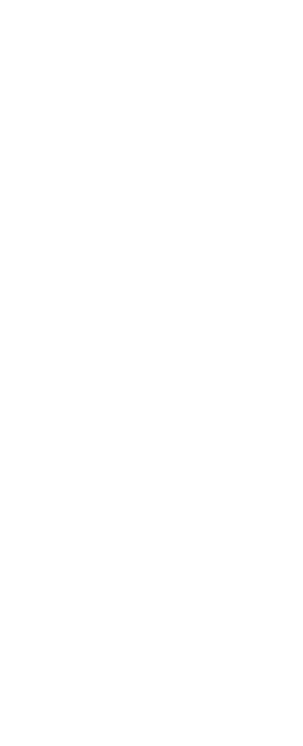
FIGURE 7 | North – south cross-sections of (A) water temperature and (B) salinity calculated using the numerical model. Calculated values used in these fi gures are compared with the observations at the same location and time from Figure 5